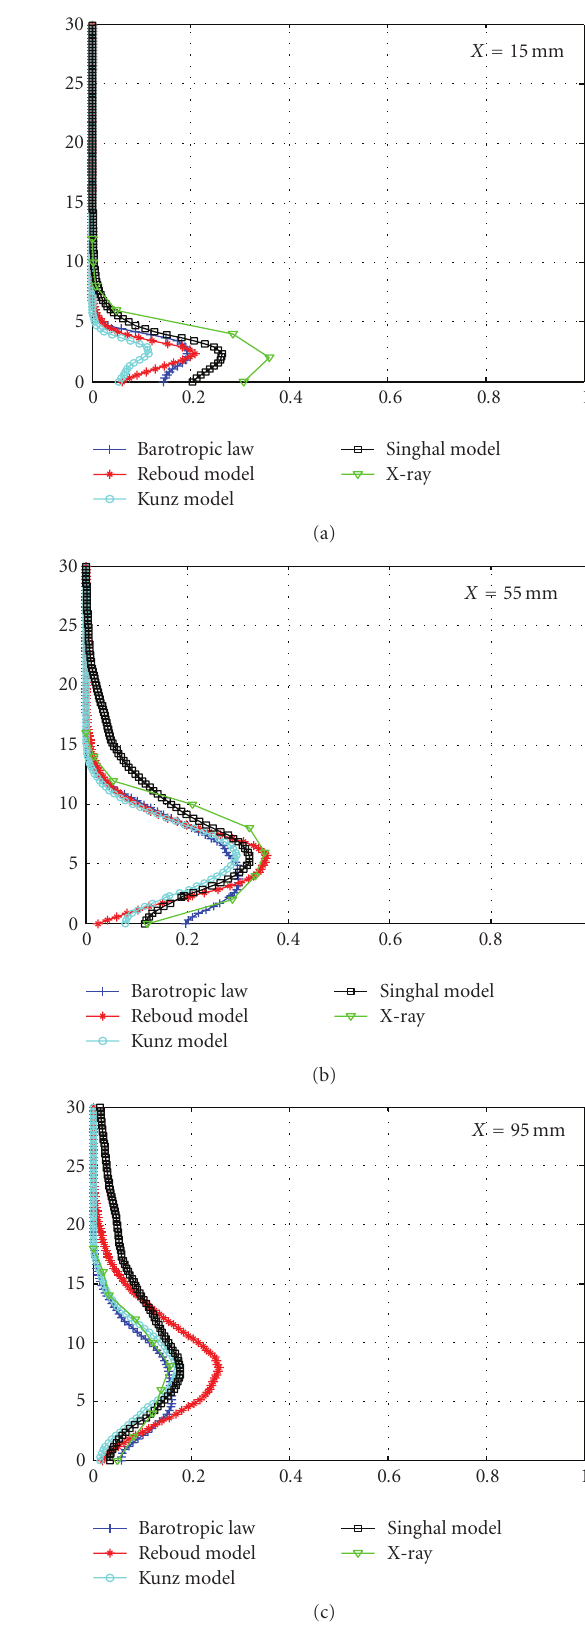
Figure 9: Comparison between numerical and experimental void fraction distributions ( L/c = 0 . 9, V ref = 6m/s).